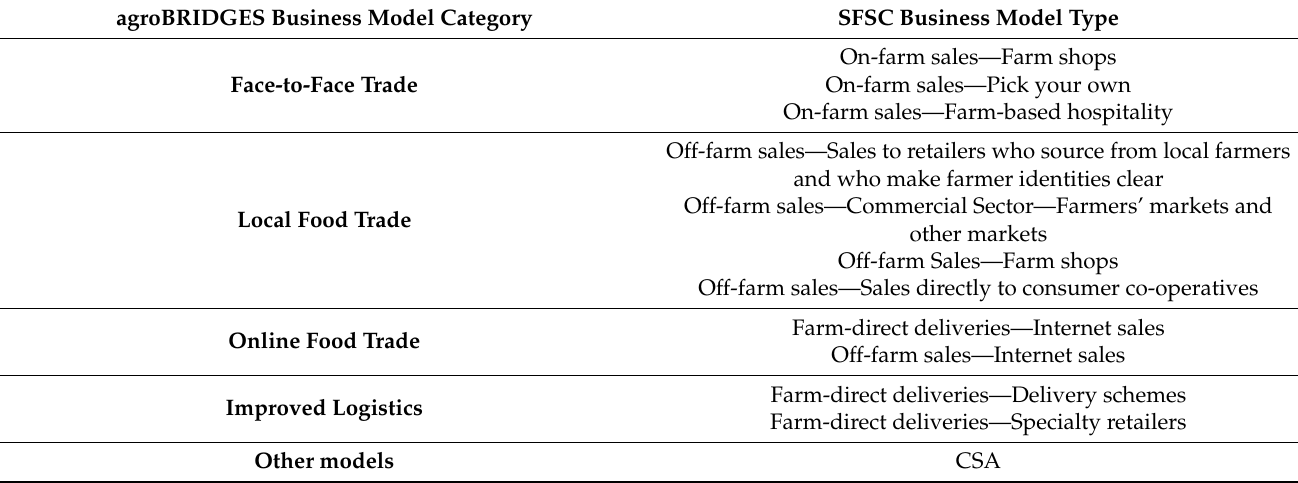
Table 1. agroBRIDGES Business